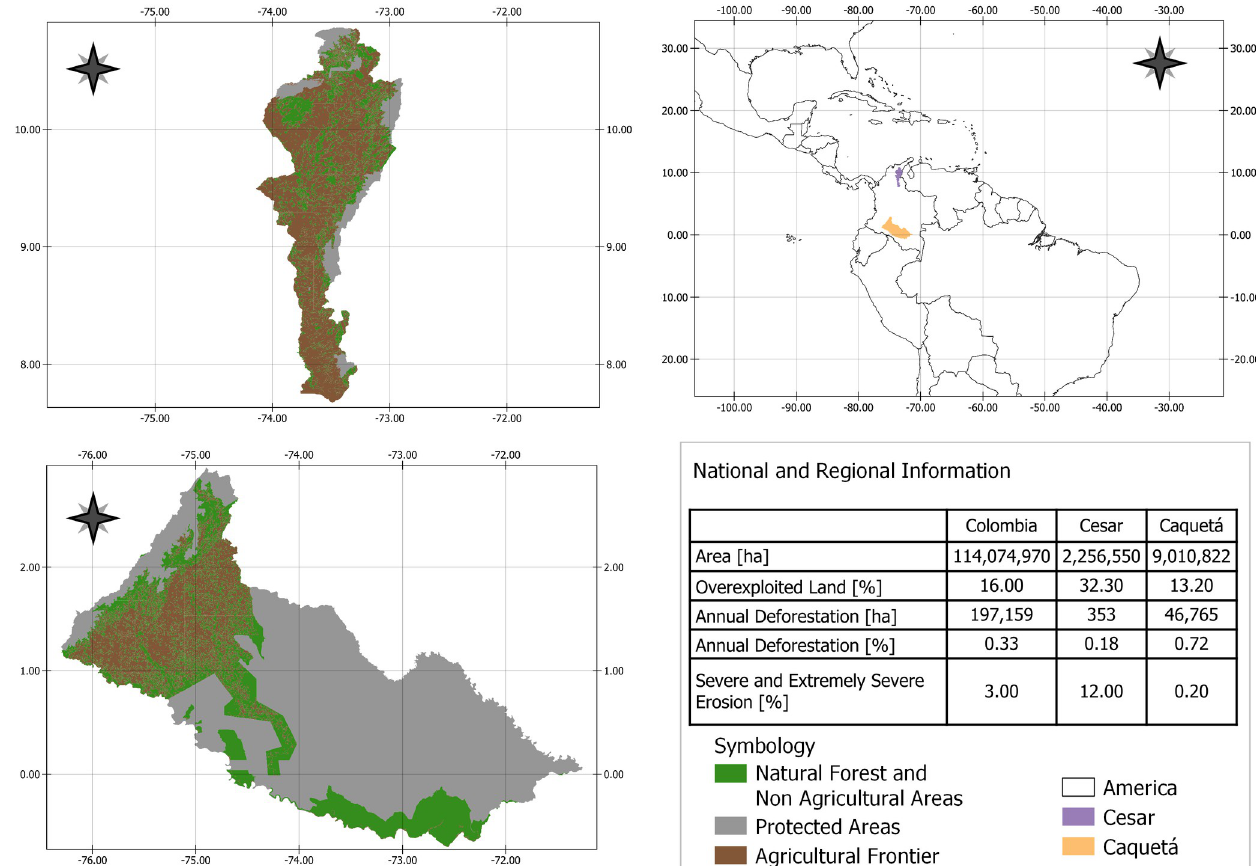
Fig 1. Study regions: Departments of Cesar and Caqueta´. Elaborated by authors. America map obtained from GADM (free available at: https://gadm.org/), and the Agricultural frontier of Cesar and Caqueta´ shape obtained from Unidad de Planificación Rural Agropecuaria–UPRA (free available at: https://sipra. upra.gov.co/). The data contained in the table was taken from the following official sources in Colombia: SIPRA, UPRA; IGAC, SMBYC, IDEAM.